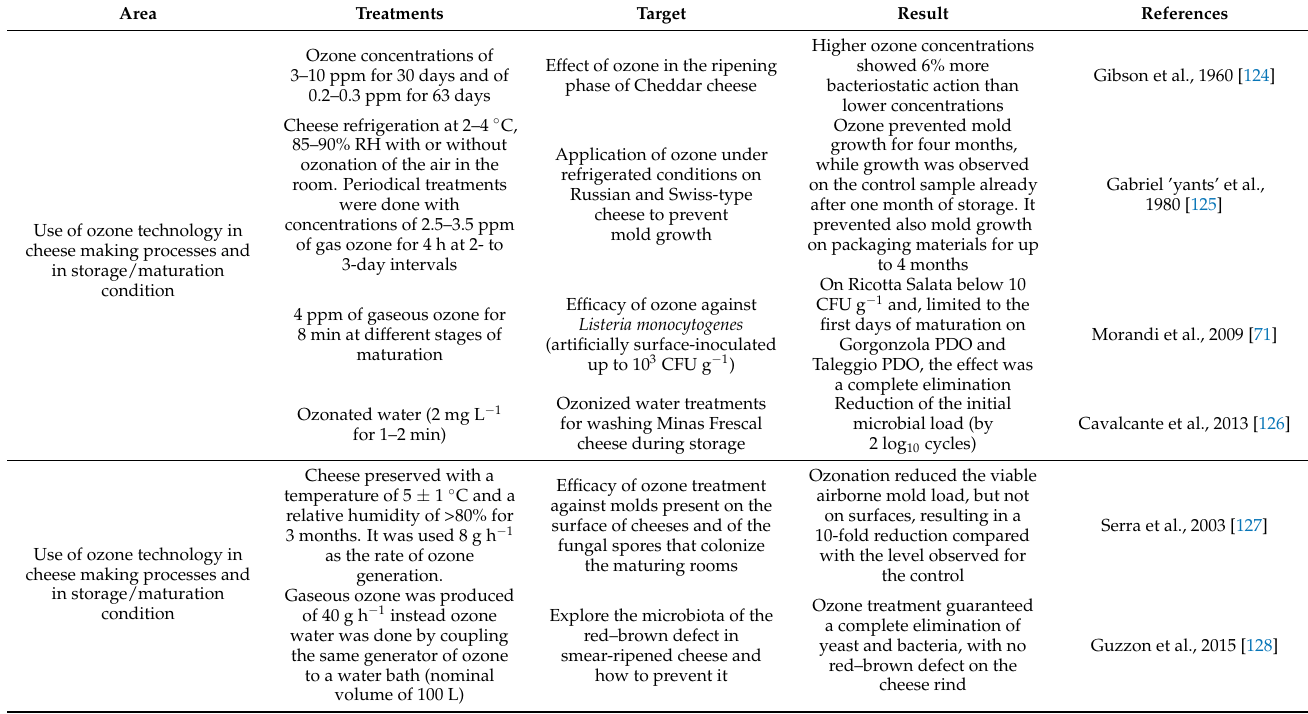
Table 6. Use of ozone technology in cheese making processes and in storage/maturation